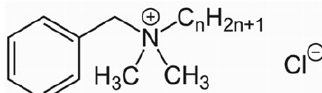
Table 1. Optimum extraction-spectrophotometric conditions. Extraction system